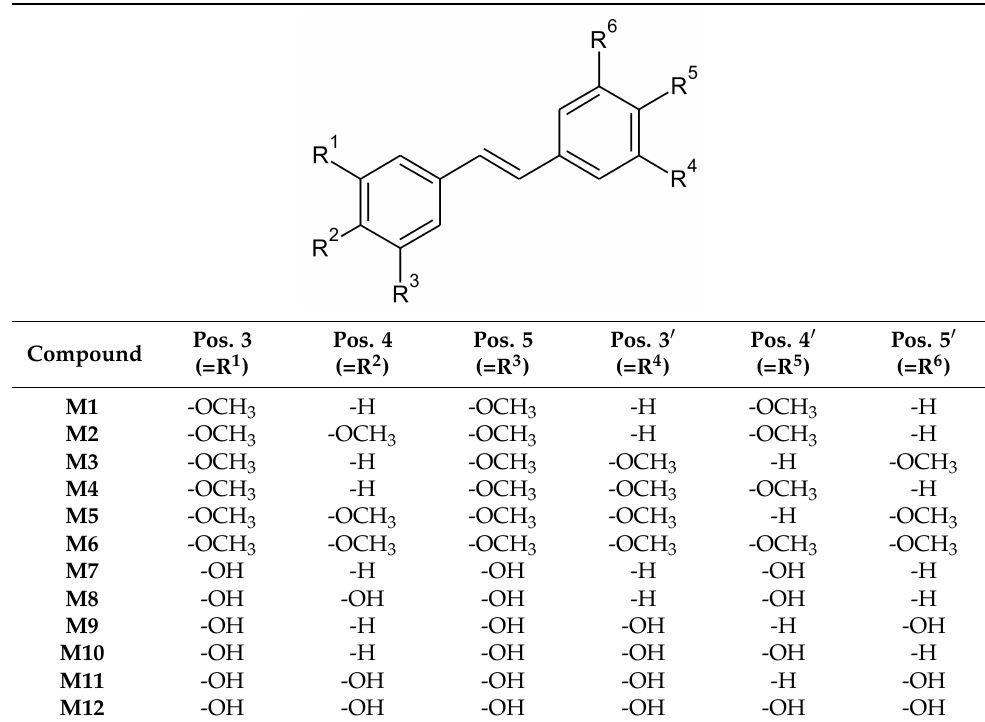
Table 1. The structure of the tested compounds M 1–12 , resveratrol, possesses the number 7 according to the code used in the table